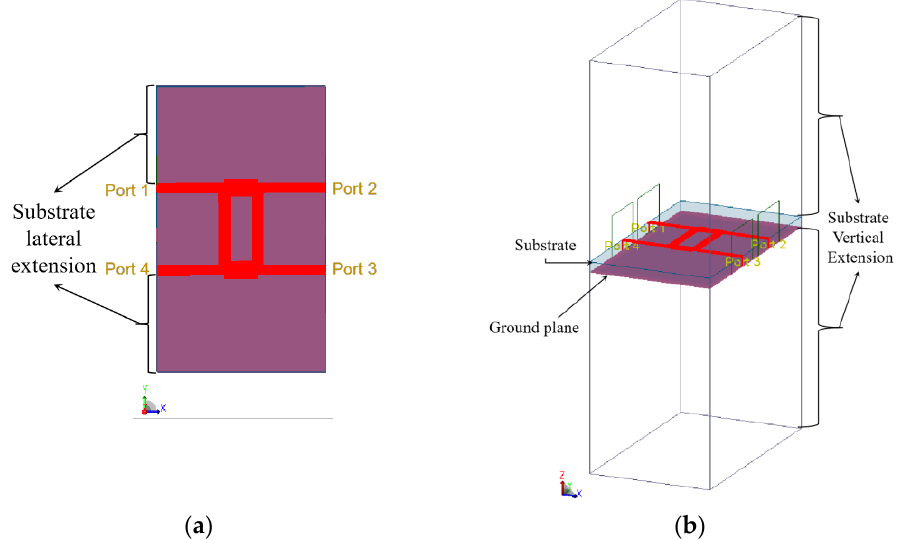
Figure 6. ( a ) Topview and ( b ) isometric view of the 3D FEM simulation model of the 90° hybrid coupler in ADS.